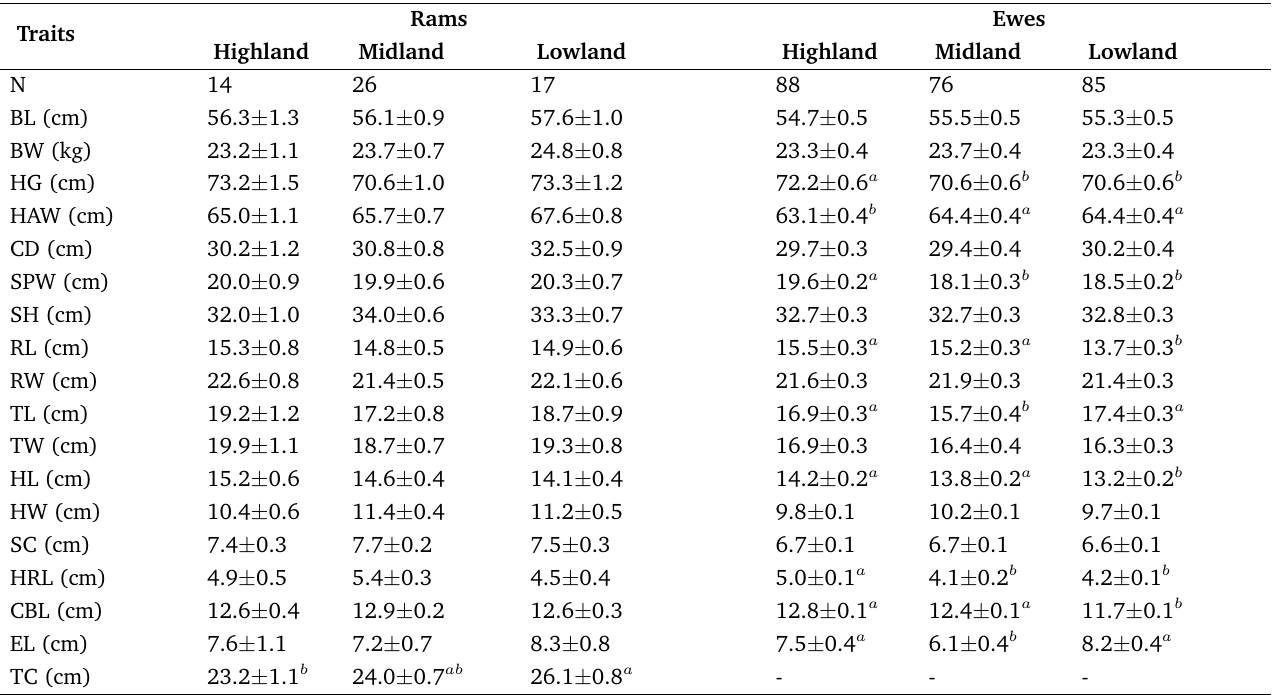
Table 4. Pairwise mean comparison (least square means and standard errors) for the effect of agro-ecological zonewithin each sex. Means within a column bearing different superscripts are significantly different; a is given to the highest